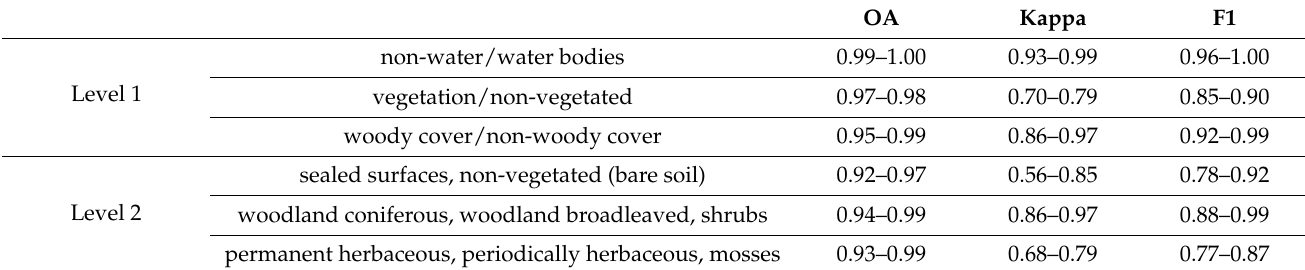
Table 5. Variability of Overall accuracy (OA), Kappa coefficient and F1 score values for the hierarchical classification at Level 1 and 2—for the six Sentinel-2 granules.